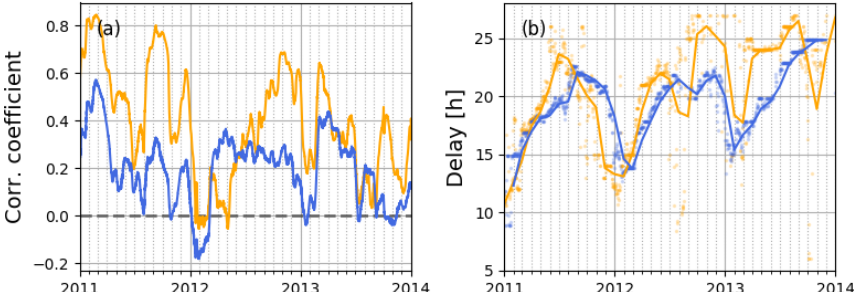
Figure 3. Plot (a) shows the correlation coefficients and plot (b) the delays calculated with a fixed location (blue) and a fixed local time (orange). The fixed location is Rome (41.8 ◦ N, 12.5 ◦ E) and the fixed local time is 12:00 at 40 ◦ N. The correlation coefficients and delays were calculated using a time window of approximately 90d and a step size of 1h with TEC and EUV data. The delays at an hourly resolution are shown by dots and the monthly means of the delays are shown as solid